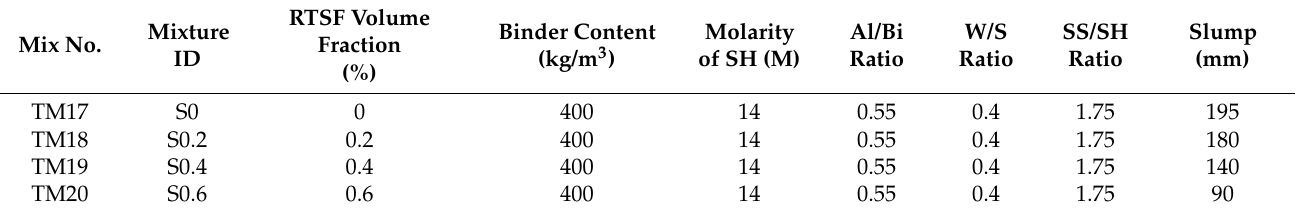
Table 9. Mix proportion of fiber-reinforced alkali-activated slag-based concrete (FR-AASC) and corresponding slump